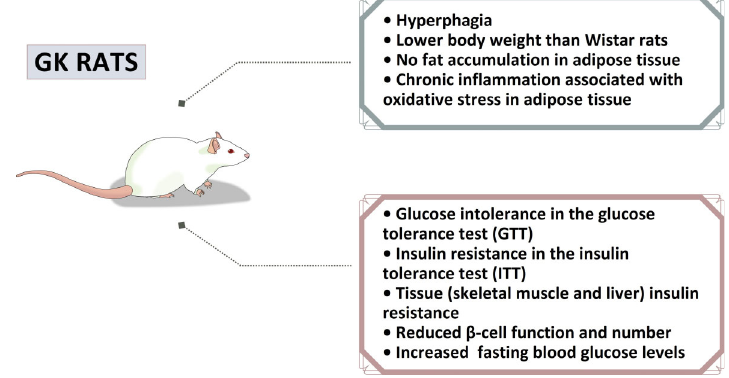
Figure 1. Main features reported in Goto-Kakizaki (GK) rats, a non-obese type 2 diabetes mellitus experimental